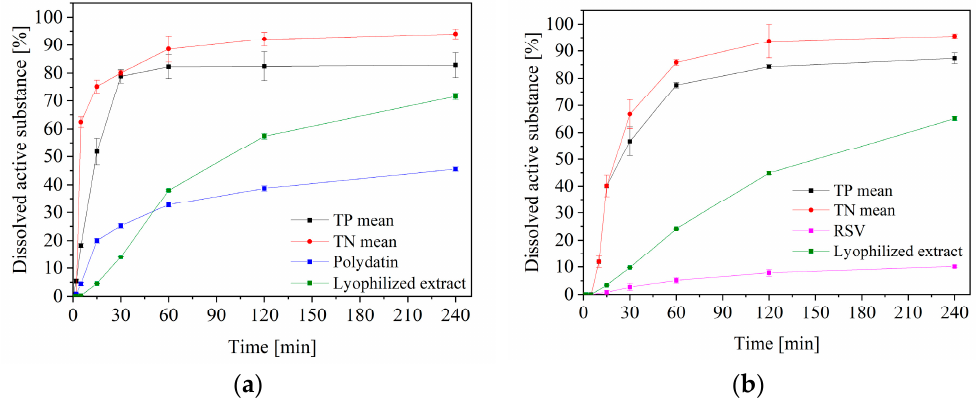
Figure 4. Averaged dissolution profiles of polydatin ( a ) and resveratrol ( b ) from the nanofiber tablets and powder tablets, in arti fi cial saliva solution at pH 6.8.